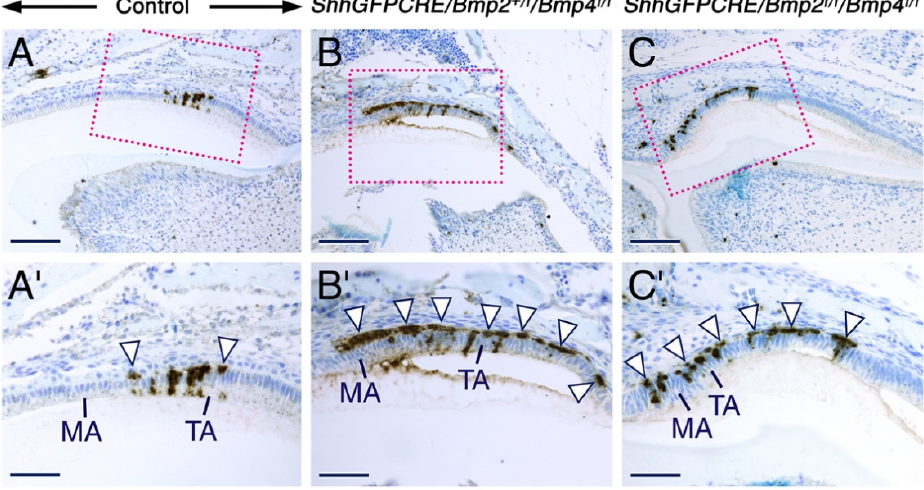
Figure 7. Combined loss of BMP2 and BMP4 signaling in the dental epithelium causes massive apoptosis in the stratum intermedium. ( A – C ) Representative immunostaining for cleaved lamin ( A ) showing the distribution of apoptotic cells (brown) in sections across molars from 12 days post- partum control ( A ), ShhGFPCRE/Bmp2 +/f /Bmp4 f/f ( B ), and ShhGFPCRE/Bmp2 f/f /Bmp4 f/f ( C ) mice. ( A’ –